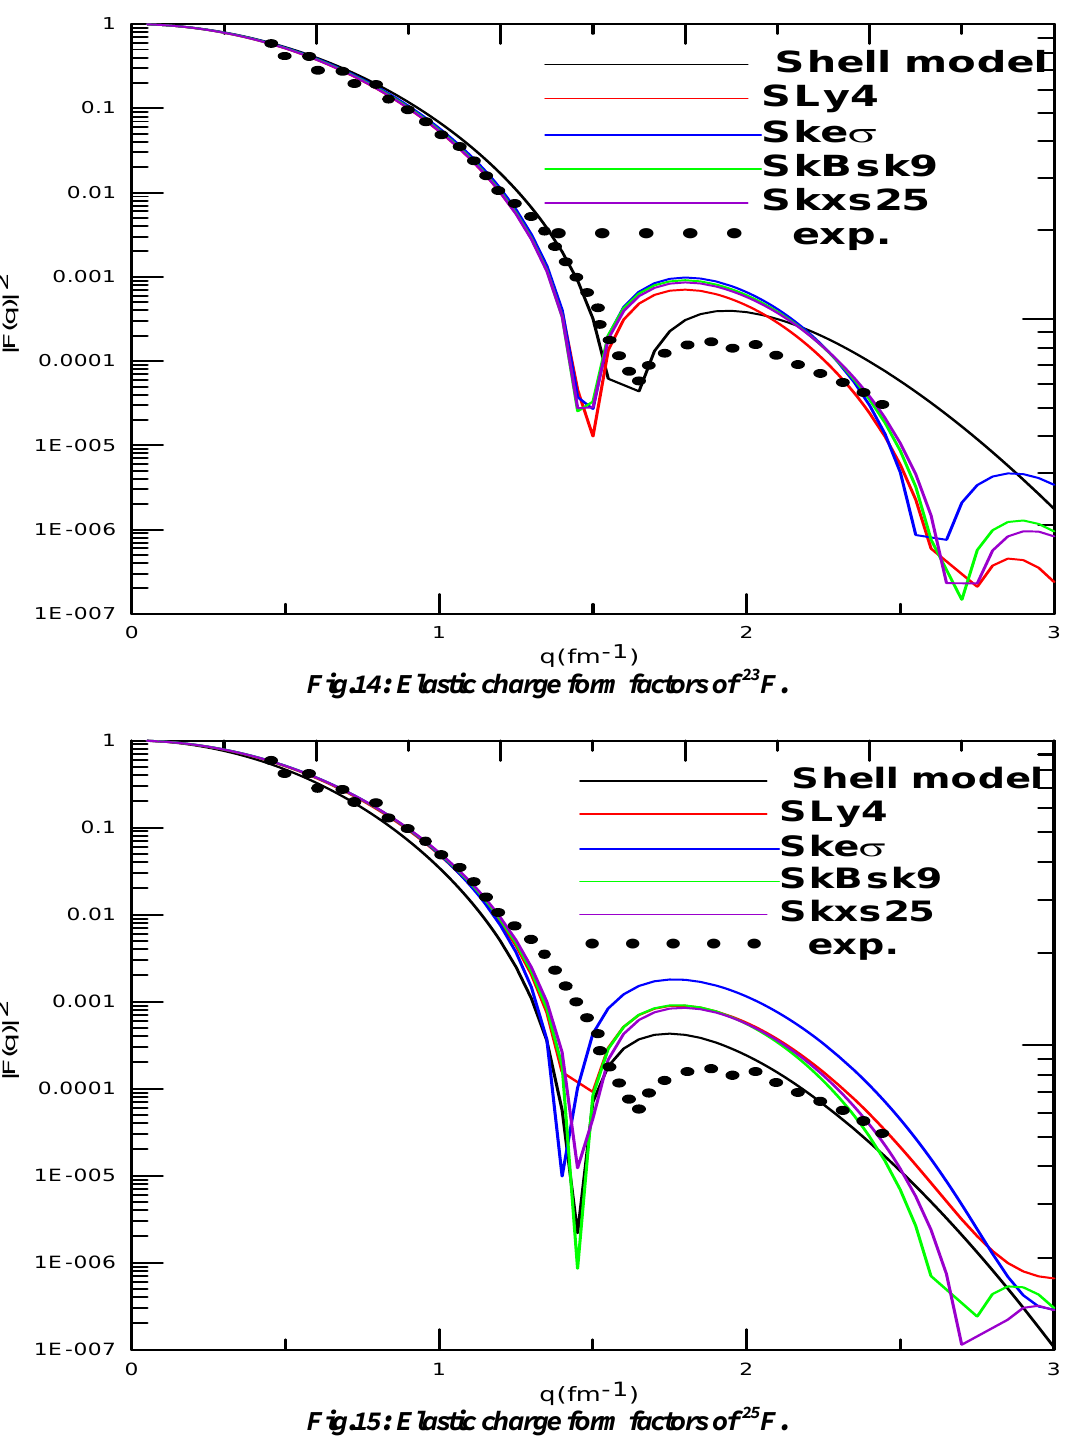
Fig.15: Elastic charge form factors of 25